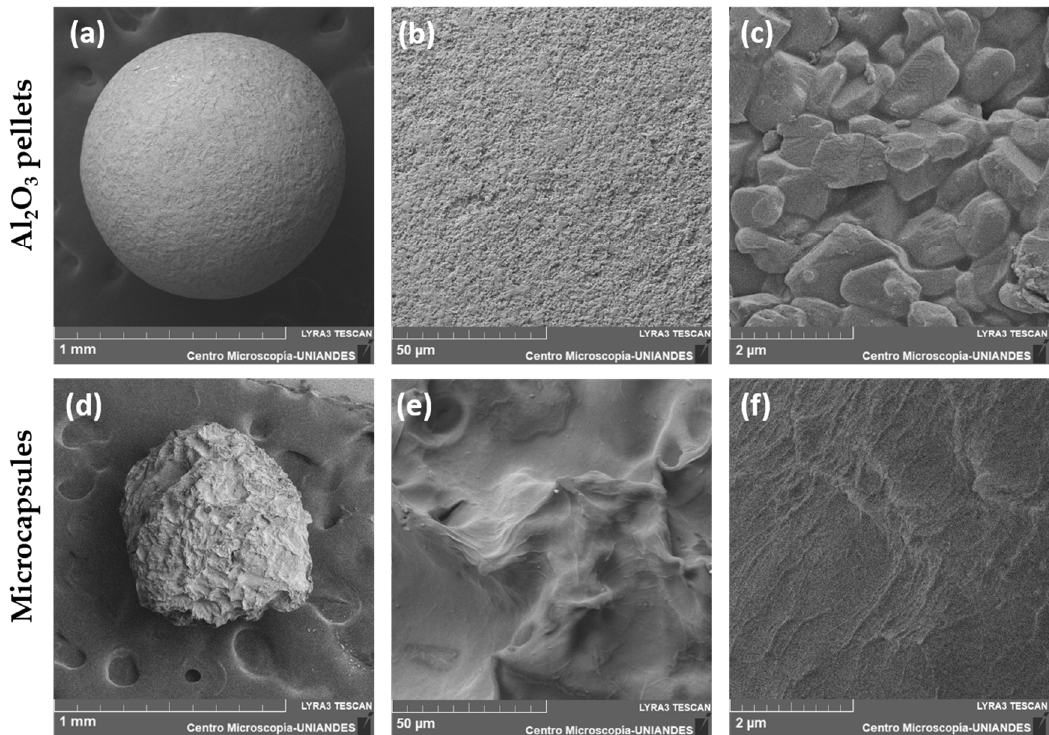
Figure 5. SEM micrographs of laccase ‐ Al 2 O 3 pellets and laccase ‐ alginate microcapsules. Observation was carried out with a magnification of ( a , d ) 150×, ( b , e ) 2000× and ( c , f ) 40,000× after 7 days of fabri ‐